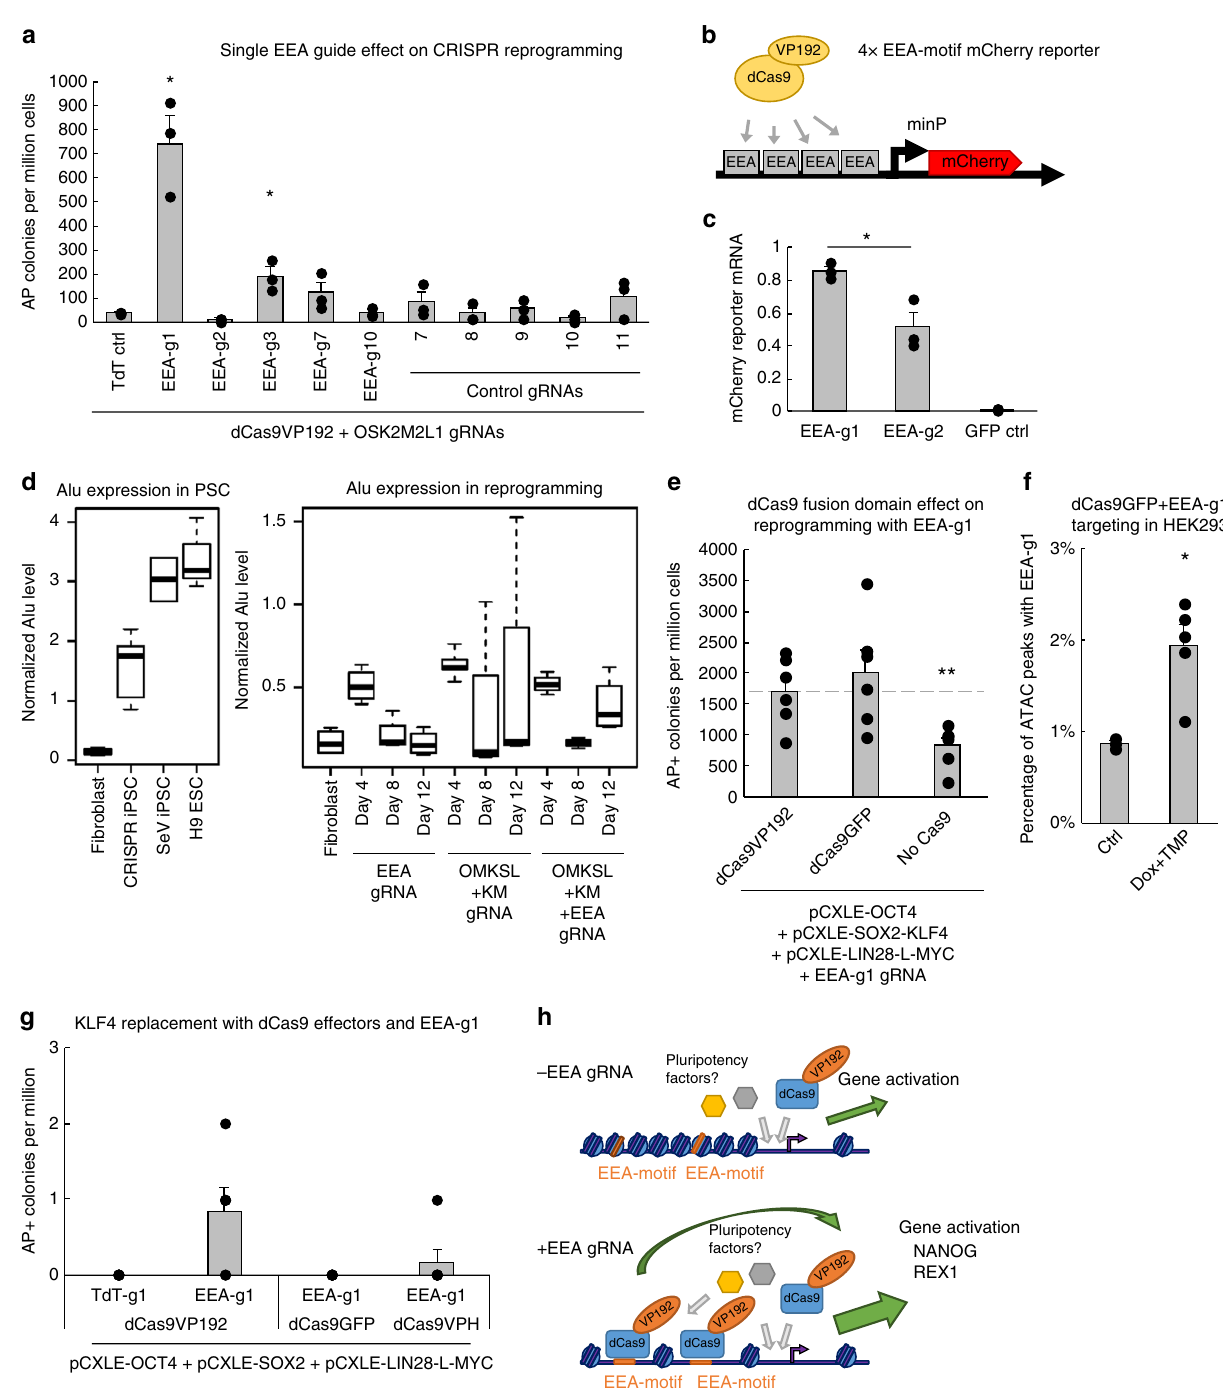
Fig. 6 EGA-enriched Alu-motif targeting is associated with activation and chromatin opening. a Effect of single EEA-motif targeting gRNAs (Fig. 1e) on CRISPRa reprogramming ef fi ciency of HFFs. n = 3, data are from three independent experiments. b Schematic representation of EEA-motif reporter plasmid activation. c qRT-PCR quanti fi cation of mCherry reporter activation with EEA-motif gRNAs 1 and 2 in reporter transfected HEK293 relative to fi ve gRNAs. EEA-g1 activates the reporter with higher ef fi ciency than EEA-g2 ( P = 0.02). n = 3, three independent experiments. d Expression of Alu derived transcripts in STRT-seq data of pluripotent stem cells and CRISPRa reprogramming cell populations. Centre line, box, and whiskers represent median, quartiles, and 1.5 IQR, respectively. e Effect of dCas9 fusion domain on reprogramming ef fi ciency in transgenic reprogramming with OCT4, SOX2, KLF4, LIN28, L-MYC, and EEA-g1. n = 6, data are from three independent experiments. f Increase in the presence of EEA-g1 sequence in ATAC-seq peaks in TetON-DDdCas9GFP and EEA-g1 expressing HEK293. ctrl n = 3, DOX + TMP n = 5. g Effect of dCas9 fusion domain on reprogramming ef fi ciency in transgenic reprogramming with OCT4, SOX2, LIN28, L-MYC, and EEA-g1. n = 6, data are from three independent experiments. h Schematic model of EEA-motif targeting in gene activation and reprogramming. Data presented as mean ± s.e.m., two tailed Student ’ s t -test. * P < 0.05, ** P <